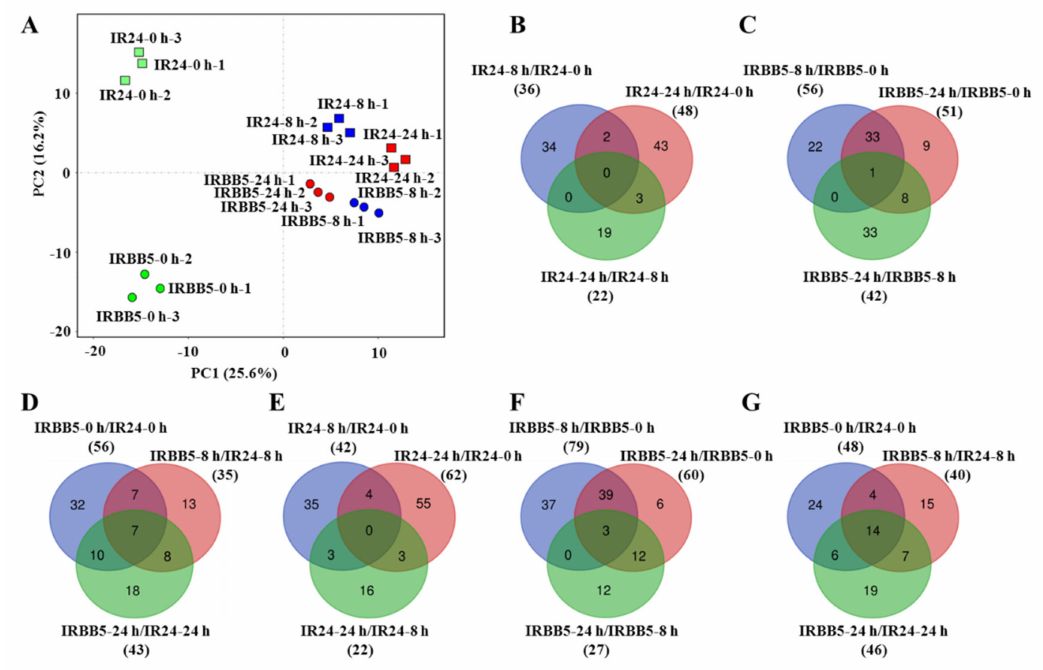
Figure 3. The overview of the miRNAs changes in IR24 and IRBB5. ( A ) Principle component analysis of detected miRNAs in small RNA sequencing data. Green, blue and red box denotes samples at 0, 8 and 24 h after treatment with Xoo strain PXO86 in IR24, respectively. Similarly, green, blue and red dot denotes samples at 0, 8 and 24 h after treatment with Xoo strain PXO86 in IRBB5, respectively. The samples at di ff erent time point have three biological replicates. ( B – D ) Venn diagrams of up-regulated di ff erentially expressed miRNAs (DE miRNAs) in IRBB5 and / or IR24 after PXO86 strain infection. ( E – G ) Venn diagrams of down-regulated DE miRNAs in IRBB5 and / or IR24 after PXO86 strain